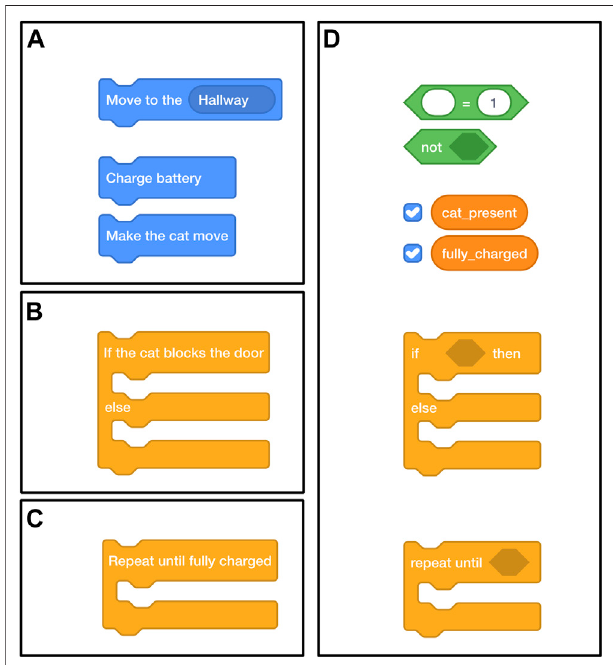
FIGURE4| Theblocksusedinthenavigationtask,illustratingtheblocks used in the different programming statements subtasks: (A) block statements only, (B) a conditional, (C) a loop, and a conditional and loop that require (D) variables.